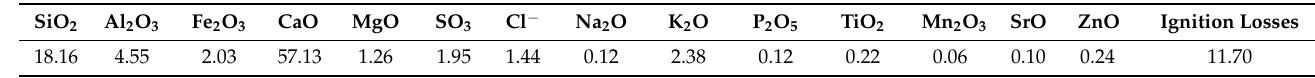
Figure 5. TG-DCS analysis of CKD. Table 5. Chemical composition of CKD, mass %.